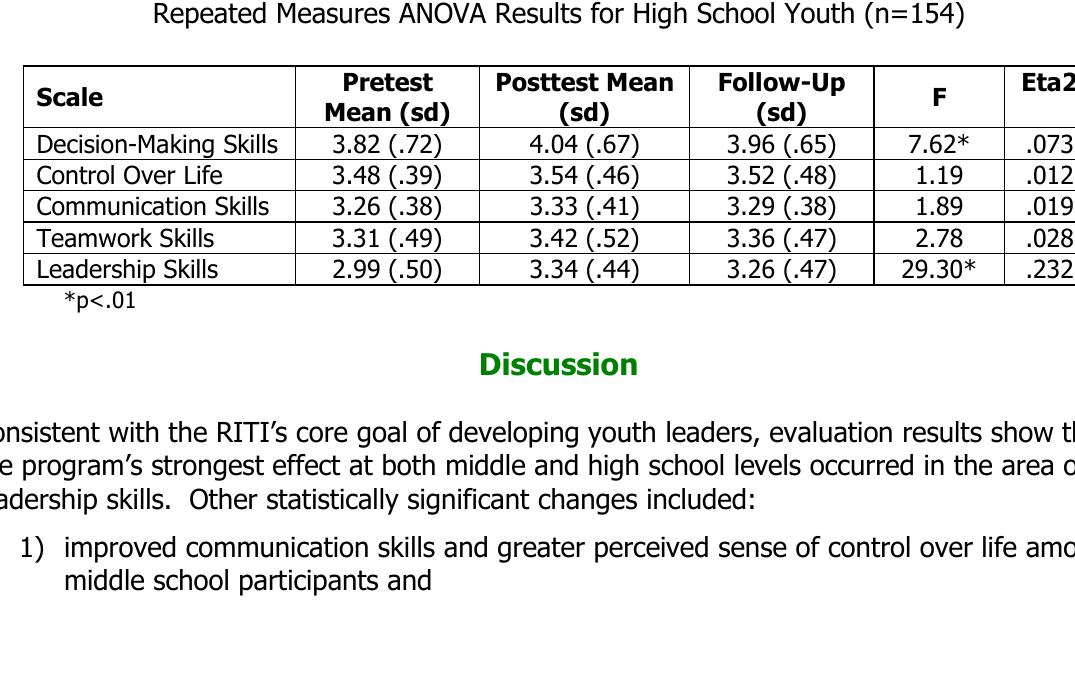
Repeated Measures ANOVA Results for High School Youth